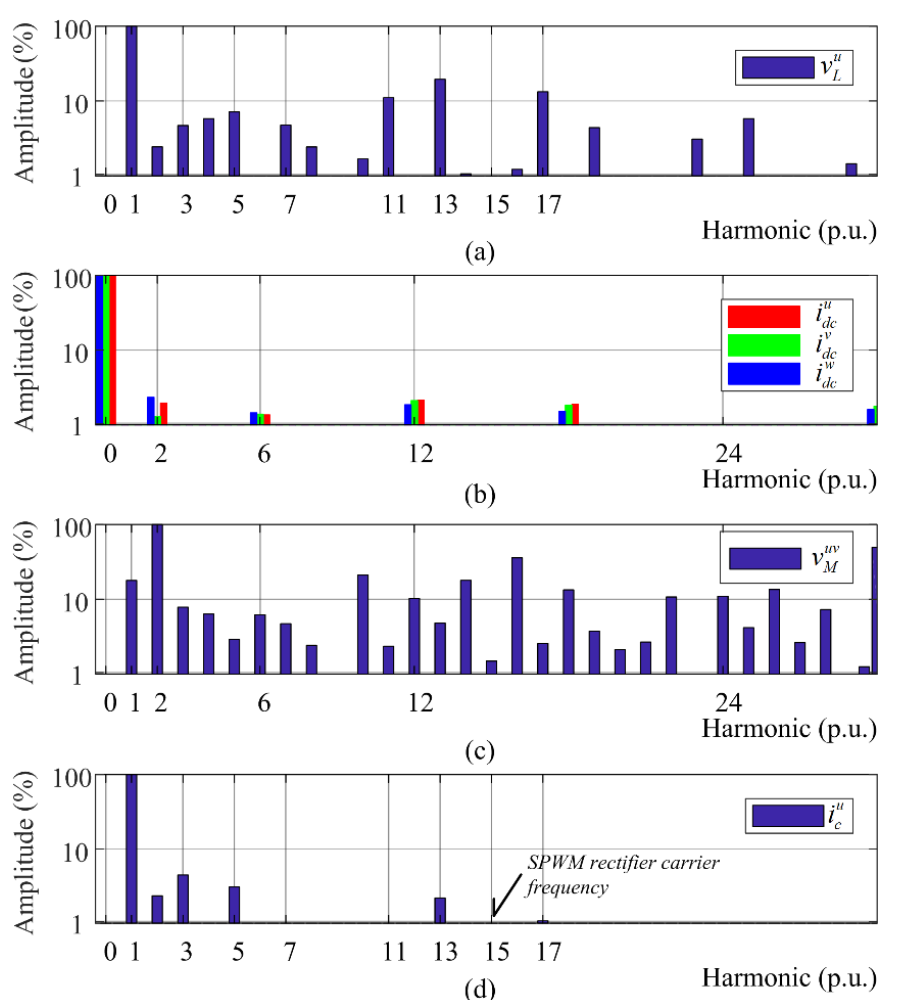
Figure 10. Spectrum of experimental waveform presented in Figure 9, per unit (p.u) with respect to 50 Hz; ( a ) load voltage; ( b ) DC currents in each cell; ( c ) magnetic coupling voltage; ( d ) cell input current.